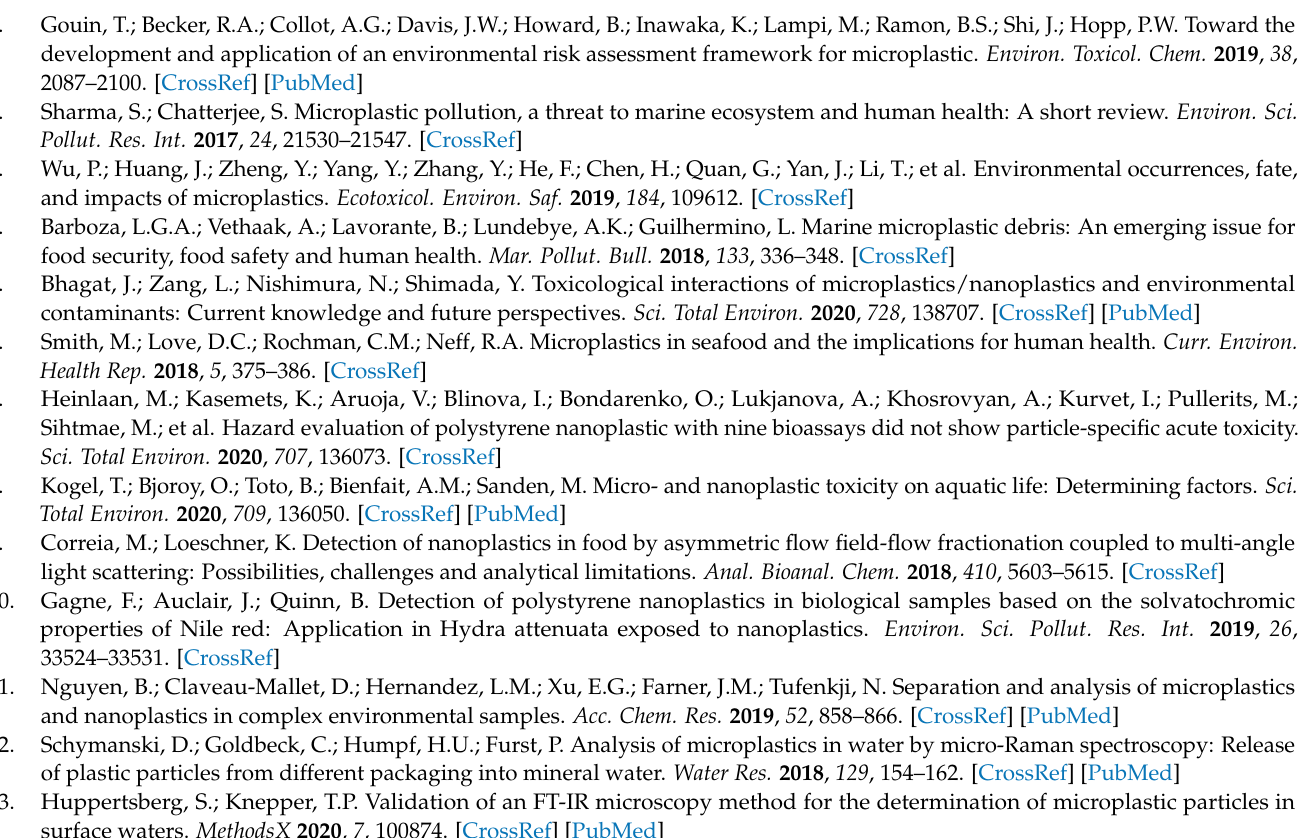
sample binding (a) the top of the LSPR chip, and (b) the side of the LSPR chip; Figure S4: UV-Vis measurement results obtained via (a) Non-Sandwich assay and (b) Sandwich assay of 75~106 µ m PS fragments; Figure S5: Dynamic light scattering (DLS) analysis of fragmented PS; Figure S6: FE-SEM measurement results for the sandwich assay of 75~106 µ m PS fragments; Figure S7. SEM image of microfluidic concentrated microwave-boiled styrofoam